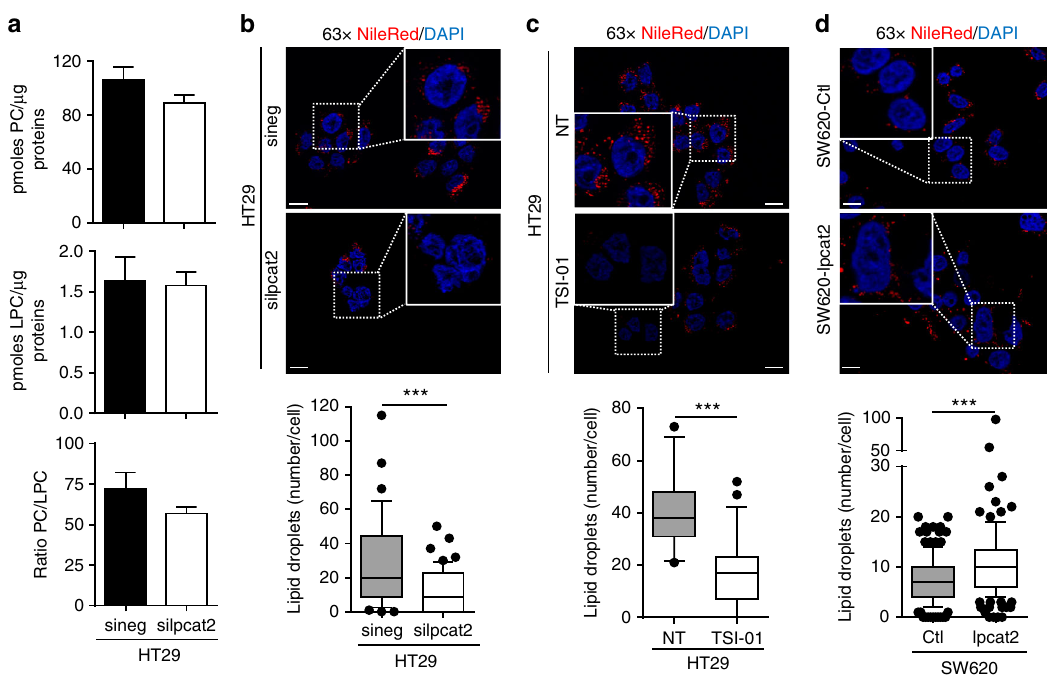
Fig. 2 LD production depends on LPCAT2 in CRC cell lines. a HT29 cells ’ PC and LPC levels assessed 72 h post-transfection with Lpcat2 siRNA (silpcat2, 10 nM) or with scrambled siRNA (sineg, 10 nM). The data were normalised to the protein content of each sample and expressed as mean ± s.e.m. b – d LD staining with Nile red ( × 63 magni fi cation, scale bar = 10 µ m) in ( b ), HT29 cells 72 h post-transfection with silpcat2 or with sineg; ( c ), HT29 cells treated for 48 h with vehicle (DMSO) or selective LPCAT2 inhibitor, TSI-01 (10 µ M); ( d ), SW620-Ctl vs. SW620 overexpressing LPCAT2 (SW620-lpcat2); number of LDs per cell and signi fi cance was evaluated by counting red lipid bodies on merged pictures (300 cells per condition) with Image J software. a – d The data presented are the combined results of three independent experiments. P values were determined by the Mann – Whitney U test. *** p <